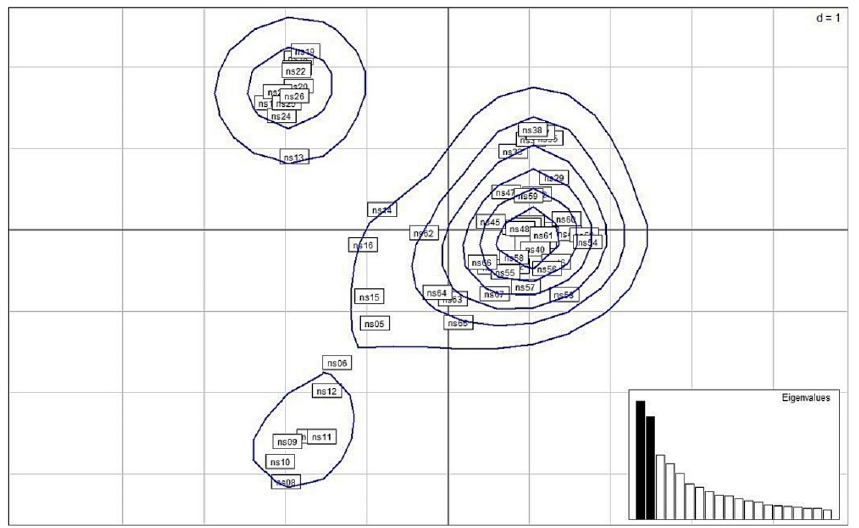
Figure 4. The principal coordinates analysis (PCoA) of N. shimadai samples from 4 populations in northern Taiwan based on the kernel density estimate of individuals using axes (PC) 1 and 2.